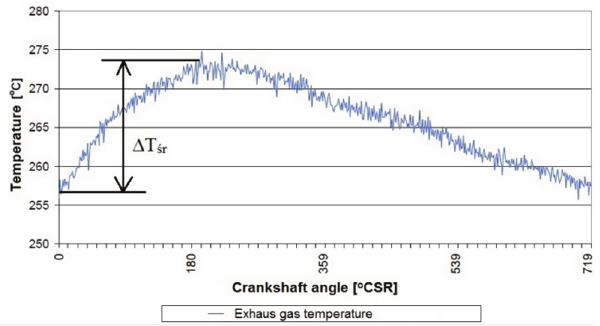
Fig. 3. The course of fluctuation of the quick-changing exhaust gas tem- perature for one engine cycle and the graphical interpretation of the peak- -to-peak temperature value